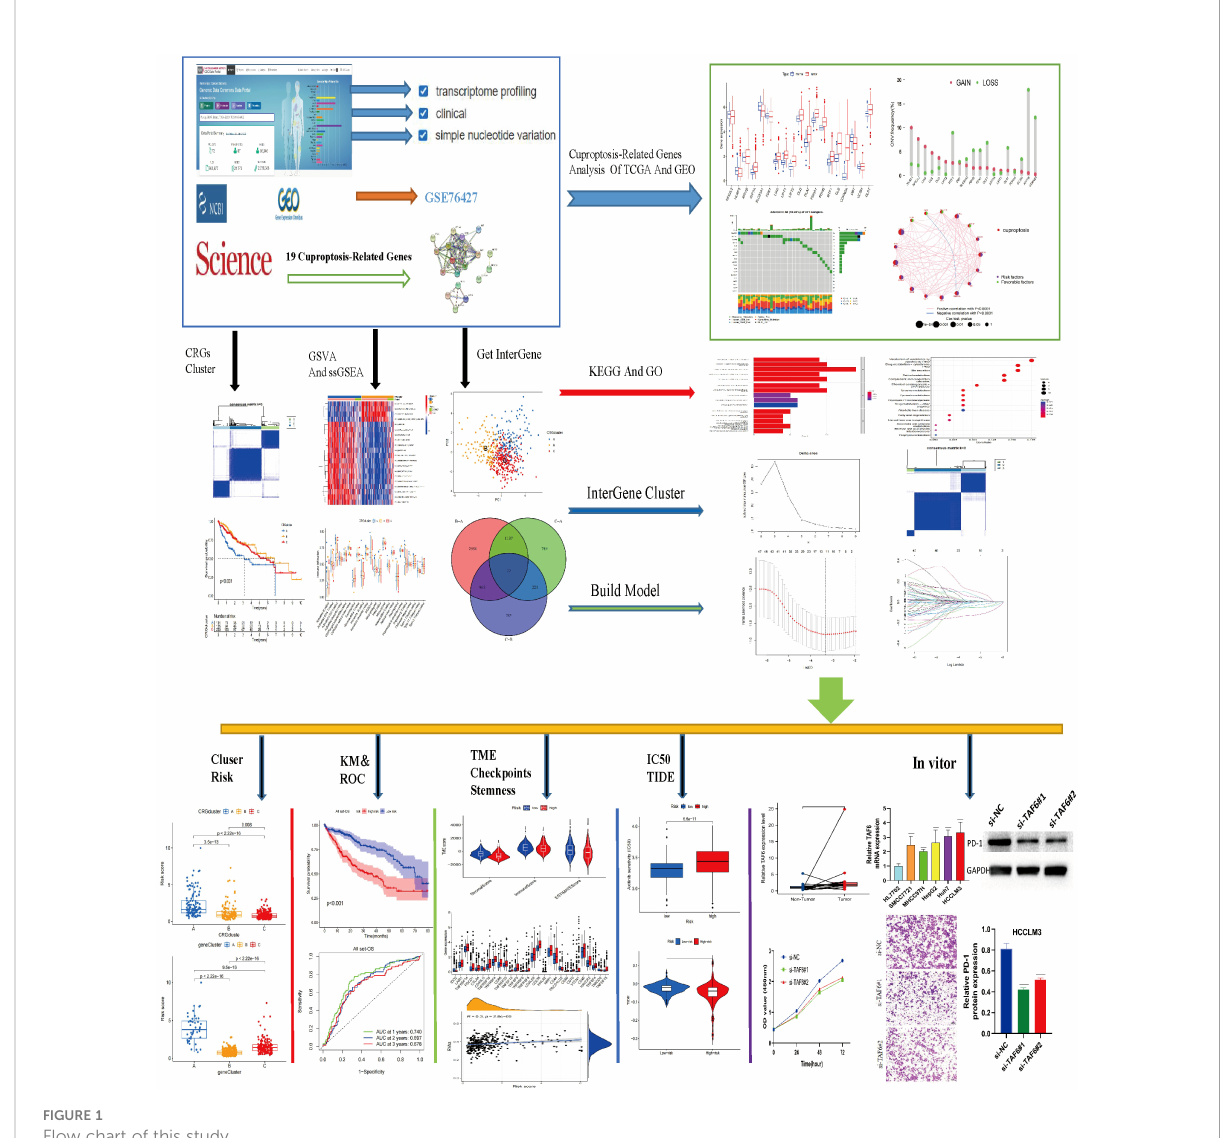
FIGURE 1 Flow chart of this